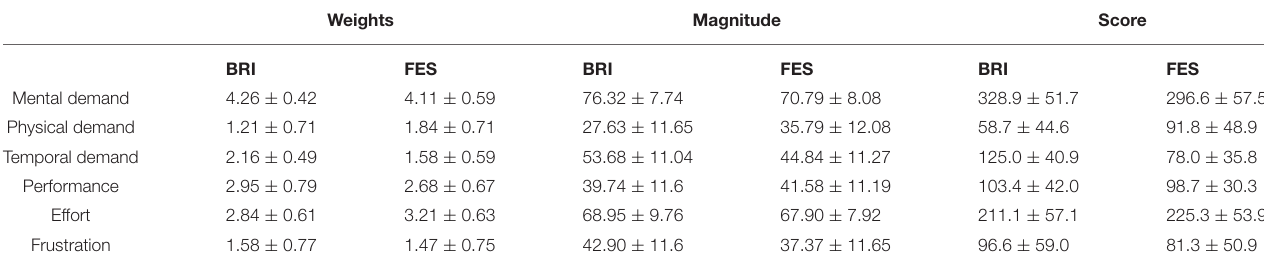
TABLE 1 | Results for the task-load measures.